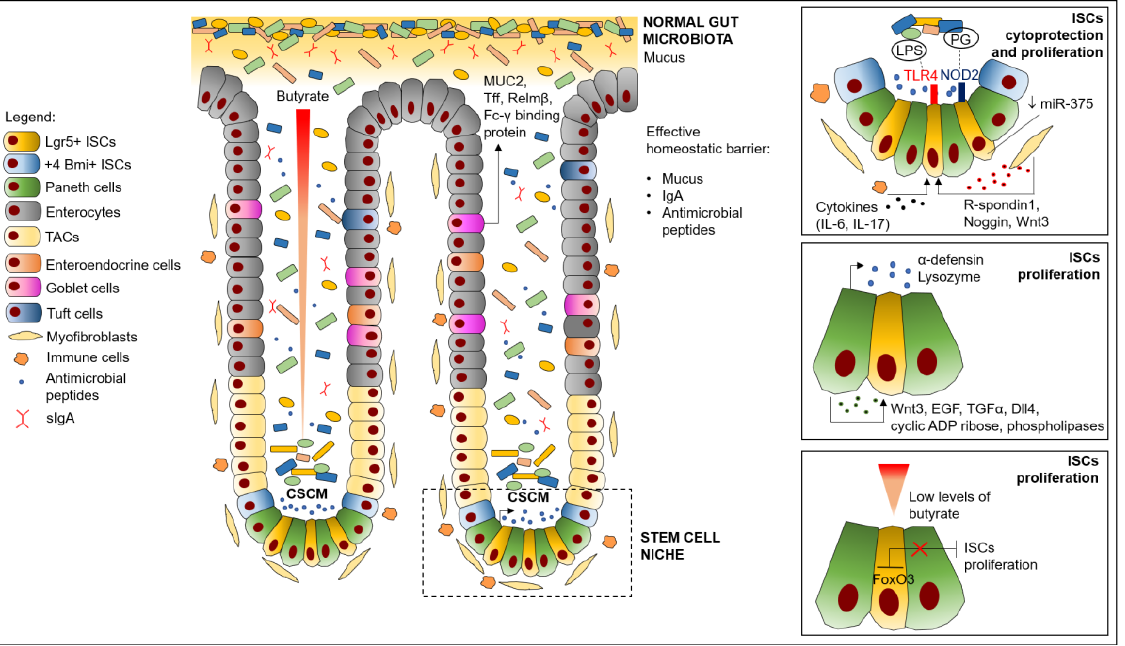
Figure 1. Effects of intestinal microbiota on ISCs homeostasis. Abbreviations: CSCM, crypt-specific core microbiota; Dll4, Notch ligand Delta-like 4; EGF, epidermal growth factor; FoxO3, Forkhead box protein; ISCs, intestinal stem cells; LPS, lipopolysaccharide; MUC2, mucin 2; NOD2, nucleotide-binding oligomerization domains; PG, peptidoglycan; Relm β , resistinlike molecule β ; ROS, Reactive Oxygen Species, sIgA, secreted immunoglobulin A; TAC, transient-amplifying cells; Tff, trefoil factor peptides; Tgf- α , transforming growth factor- α ; TLR4, Toll-like receptor